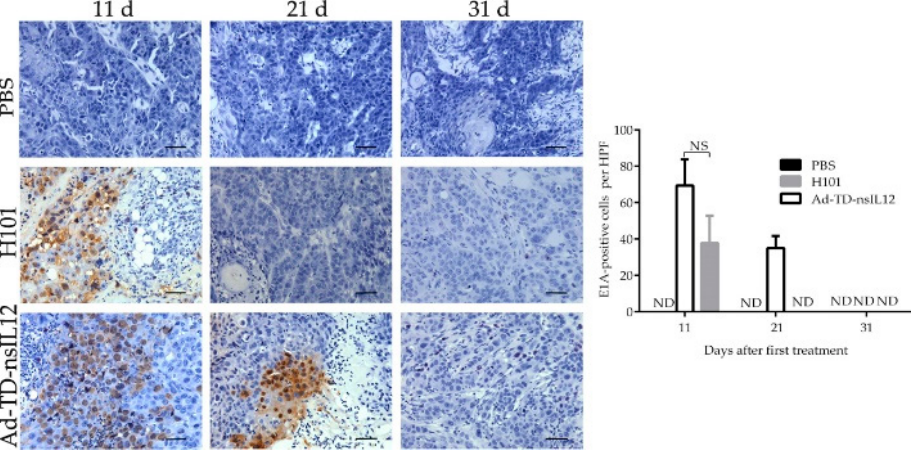
Figure 5. Ad-TD-nsIL12 persists in tumor tissue for a longer duration than H101. Tumors growing in ZZU001 were directly injected with Ad-TD-nsIL12 or H101 (5 × 10 8 PFU) on days 0, 2, 4, 6, 8, and